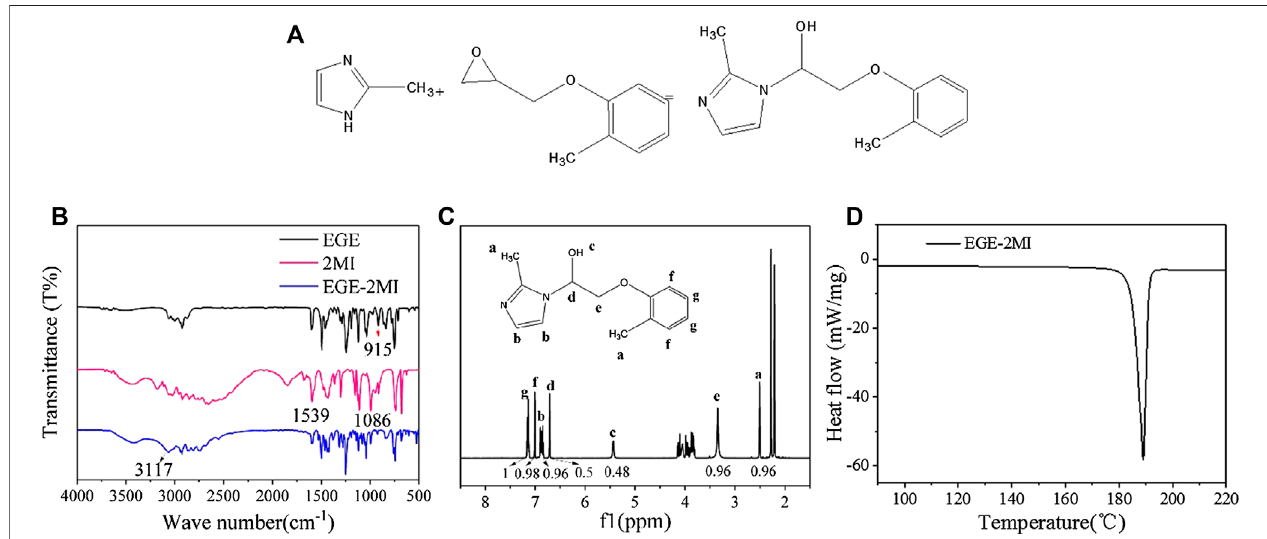
FIGURE 2 | (A) Dynamic differential scanning calorimeter curves of the Ethyl Glycidyl Ether – 2-methylimidazole (EGE – 2-MI) epoxy resin curing system at different heatingrates; (B) dynamicdifferentialscanningcalorimetercurvesofepoxyresincuredwithdifferentcuringagents; (C) plotsofln( β / T p2 )vs.1/ T p oftheEGE – 2-MIepoxy resinsystem; (D) storagestabilityofthedifferentcuringsystems; (E) observationof fl uidityofthesystemusing2-MIasthecuringagent(a),EGE – 2-MIasthecuringagent (b), and EGE – 2-MI as the curing agent with cyanate resin (CE) as a stabilizer (c); (F) mechanical properties of the different curing systems.